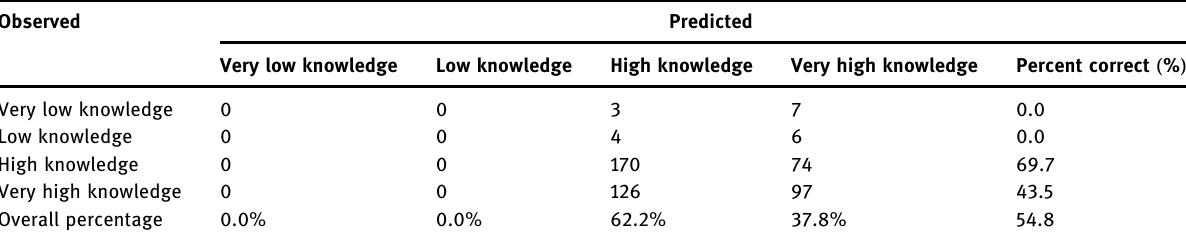
Table 6: Model prediction capacity